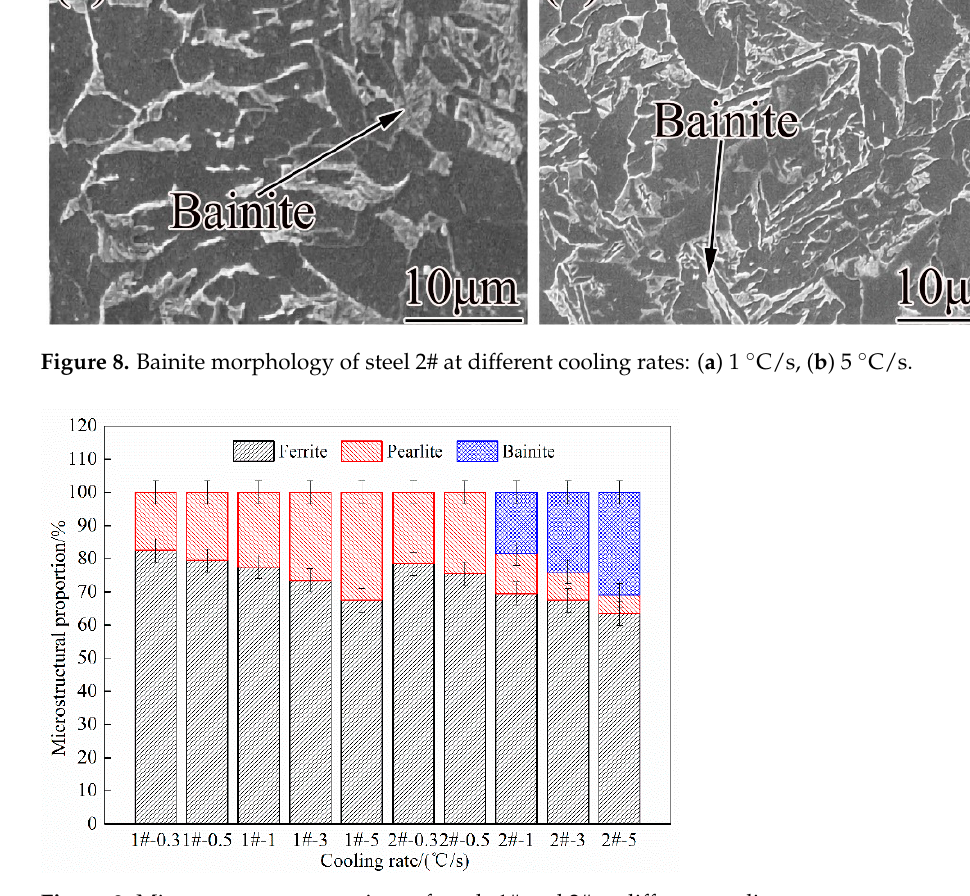
Figure 8. Bainite morphology of steel 2# at different cooling rates: ( a ) 1 °C/s, ( b ) 5 °C/s.